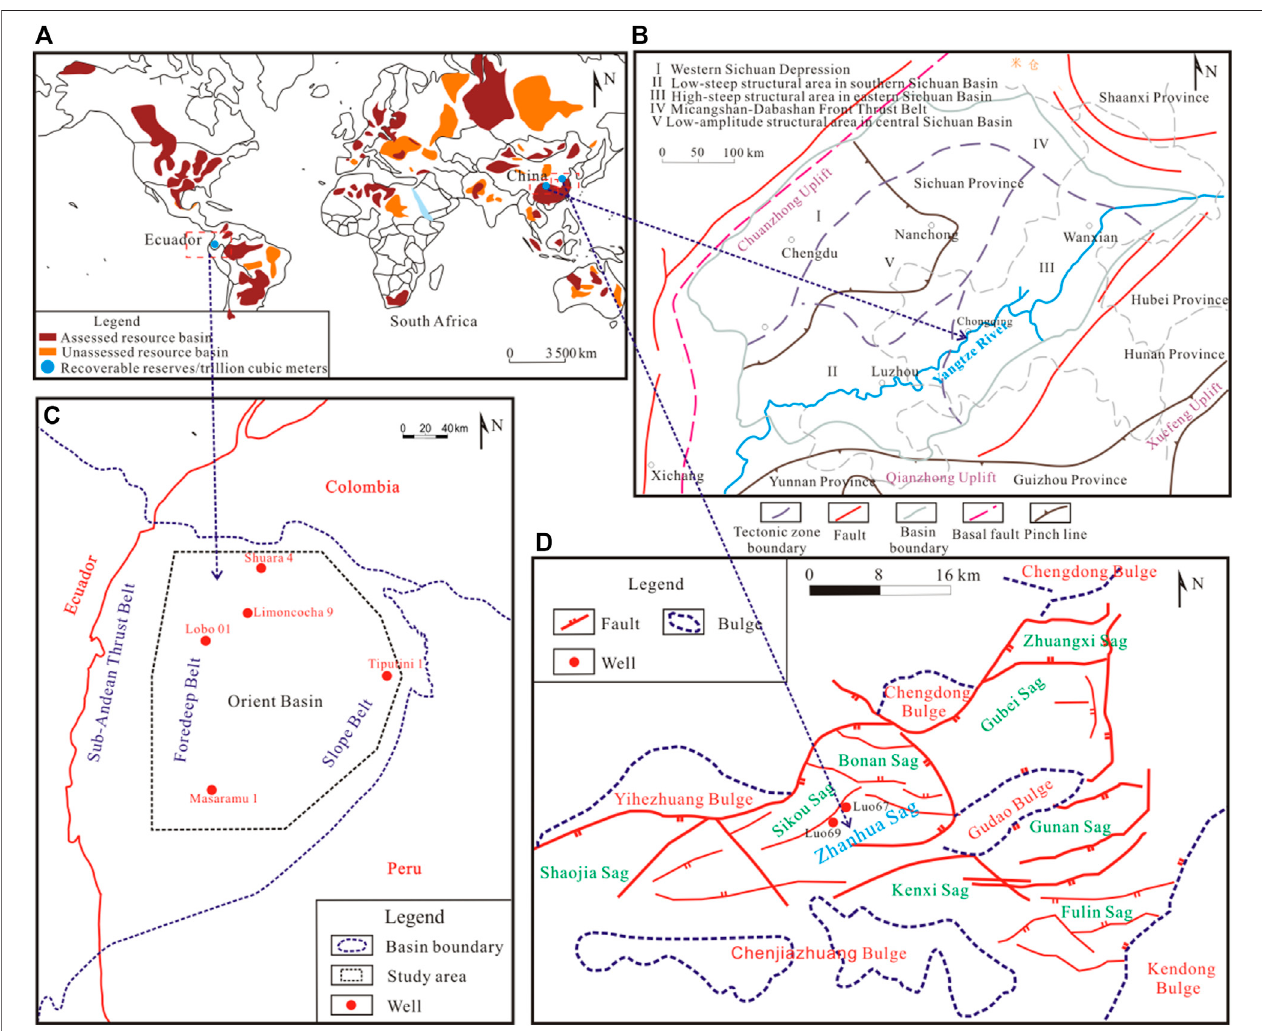
FIGURE1| Location and geologicalbackgroundofthestudy area.Notes: Thestudyareaislocated intheSichuan BasininChina,theOrientBasininEcuador and theZhanhuaSagintheBohaiBayBasininChina (A) .TheshalesamplesintheSichuanBasin (B) werecollectedfromtheSilurianLongmaxiandWufengFormations; the shale samples in the Orient Basin (C) were collected from the Cretaceous Napo Formation; and the shale samples in the Zhanhua Sag of the Bohai Bay Basin (D) were collected from the Paleogene Shahejie Formation.